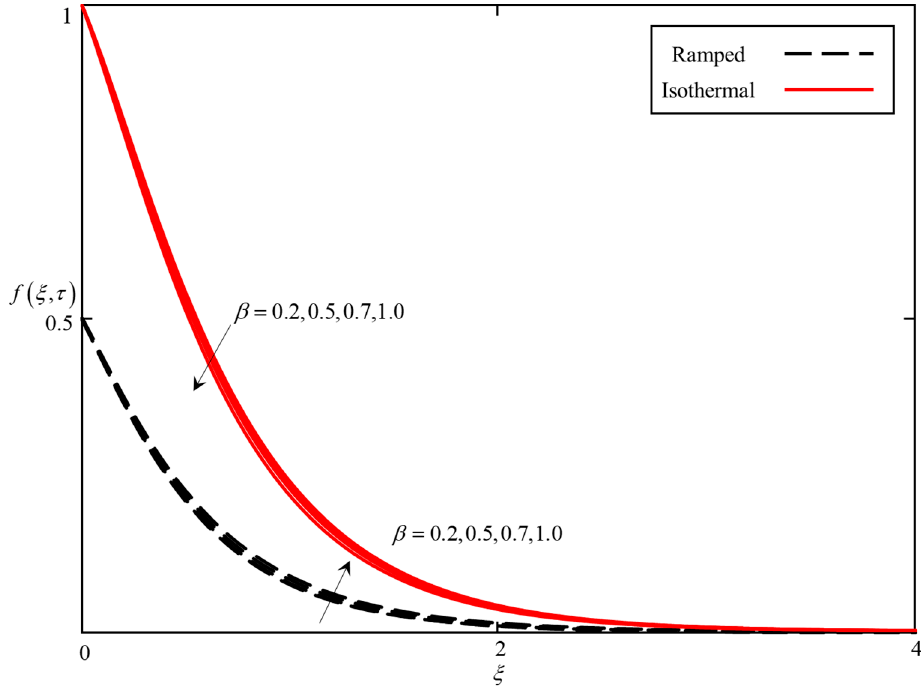
Figure 7. Consequence of β on the velocity field, when α = 0.5, φ = 0.04, λ 1 = 0.5, λ 2 = 0.5, M = 0.5, K = 0.5 Pr = 21, and Gr =